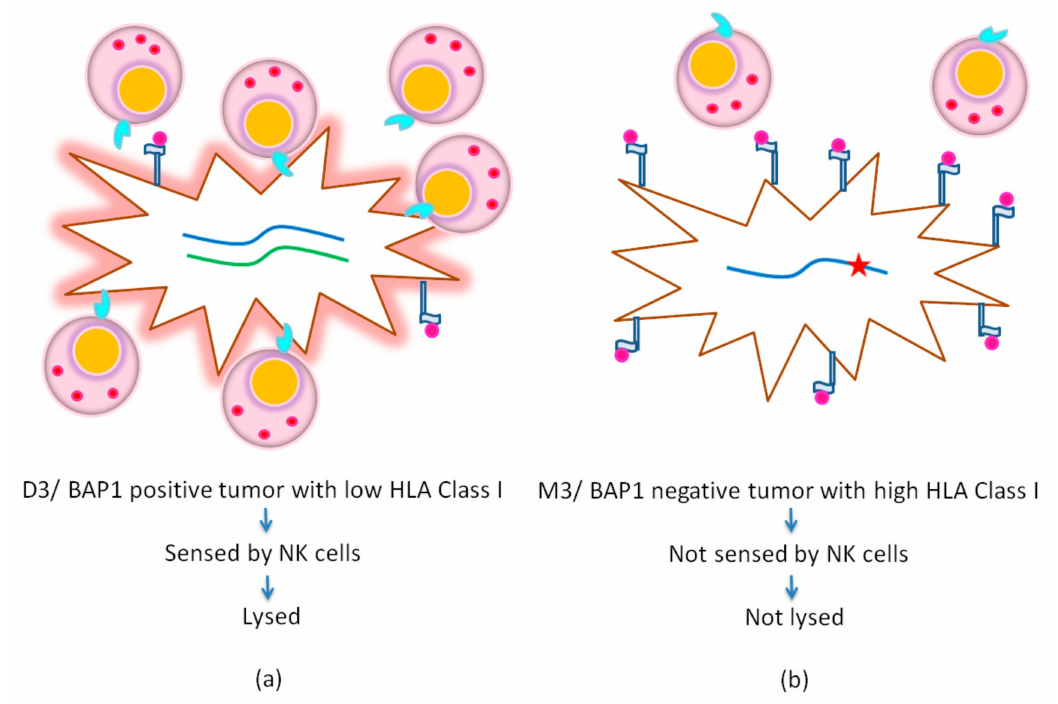
Figure 1. Schematic illustration of the relationship between the tumor’s chromosome 3 / BRCA-Associated Protein 1 (BAP1) status, its HLA expression and Natural Killer (NK) cell recognition. ( a ) Disomy 3 / BAP1-wildtype tumor: low HLA Class I expression, killed by NK cells. ( b ) Monosomy 3 / BAP1-mutated tumor: high HLA Class I expression, escapes from NK cell-mediated lysis in the